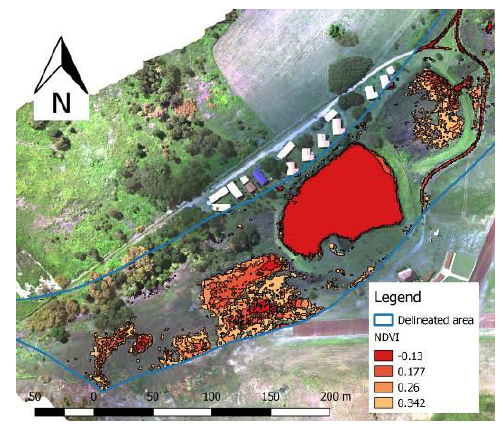
Figure 10. Low NDVI values indicating disturbed areas within the wetland